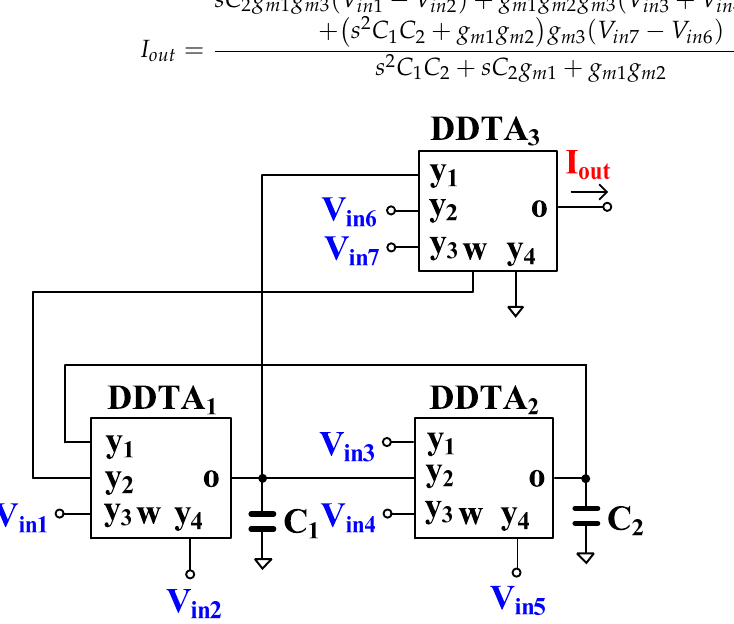
Figure 5. Modified transconductance-mode analog filter. Table 2. Obtaining variant filtering function of transconductance-mode analog filter.